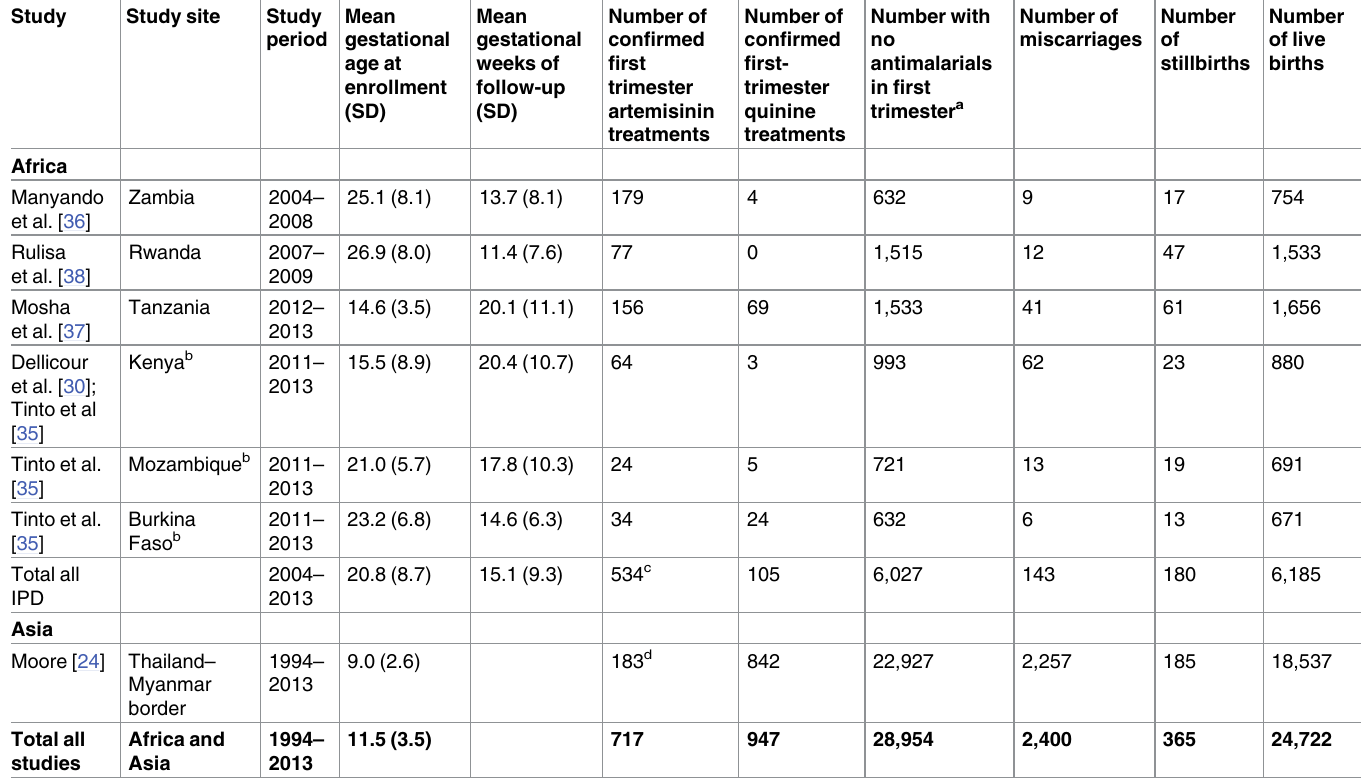
Table 1. Description of prospective cohort studies and data included in the African individual participant data meta-analysis and Asian aggre- gated data